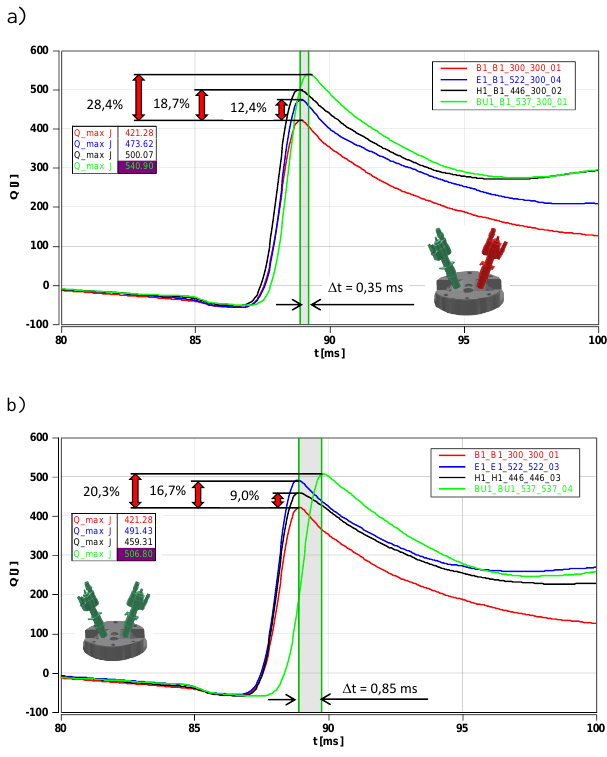
Fig. 10. Effect of fuel type on heat release: a) injection of the same fuel, b) injection of different fuels The combustion of gasoline and n-butanol mixture in re- lation to the combustion of gasoline alone resulted in: – maximum combustion pressure in the cylinder being 10% higher; changes observed for other fuel mixtures reached values up to 4%, – the pressure increase being 17% greater; combustion of the other analyzed mixtures indicates changes in this value of up to 7% in comparison, – maximum heat release rate being 22% greater; where other fuel mixtures generated smaller differences of up to 8% at most, – the maximum amount of total heat released being 22% higher; changes of this indicator for other fuel mixtures compared to gasoline were: 13% (for petrol and ethanol) and 8% (for petrol and